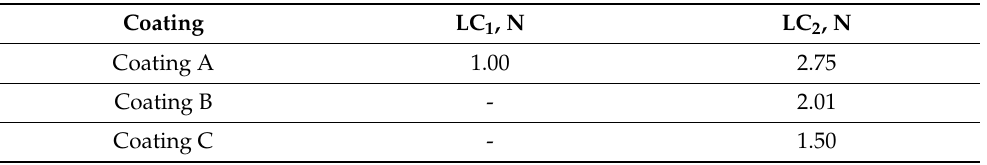
Figure 13. Evolution of coefficient of friction at different passes during repetitive wear test at 0.75 N for the three TiB 2 coatings after: ( a ) 1 pass, ( b ) 3 passes and ( c ) 5 passes. Table 4. Critical load for crack initiation in coating, LC 1 and critical load for coating failure, LC 2 obtained from ramped load scratch test for the three TiB 2